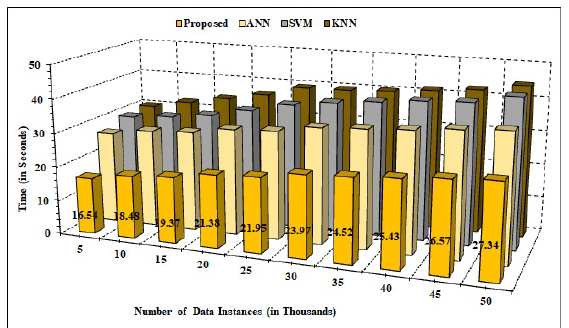
Figure 5. Cumulative Temporal Delay.